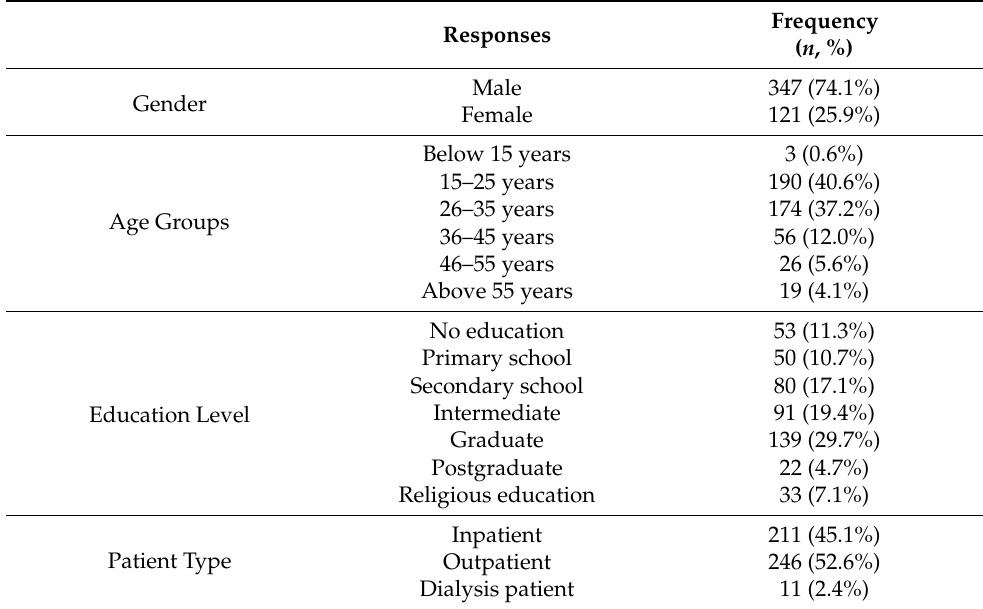
Table 2. Demographic characteristics of the